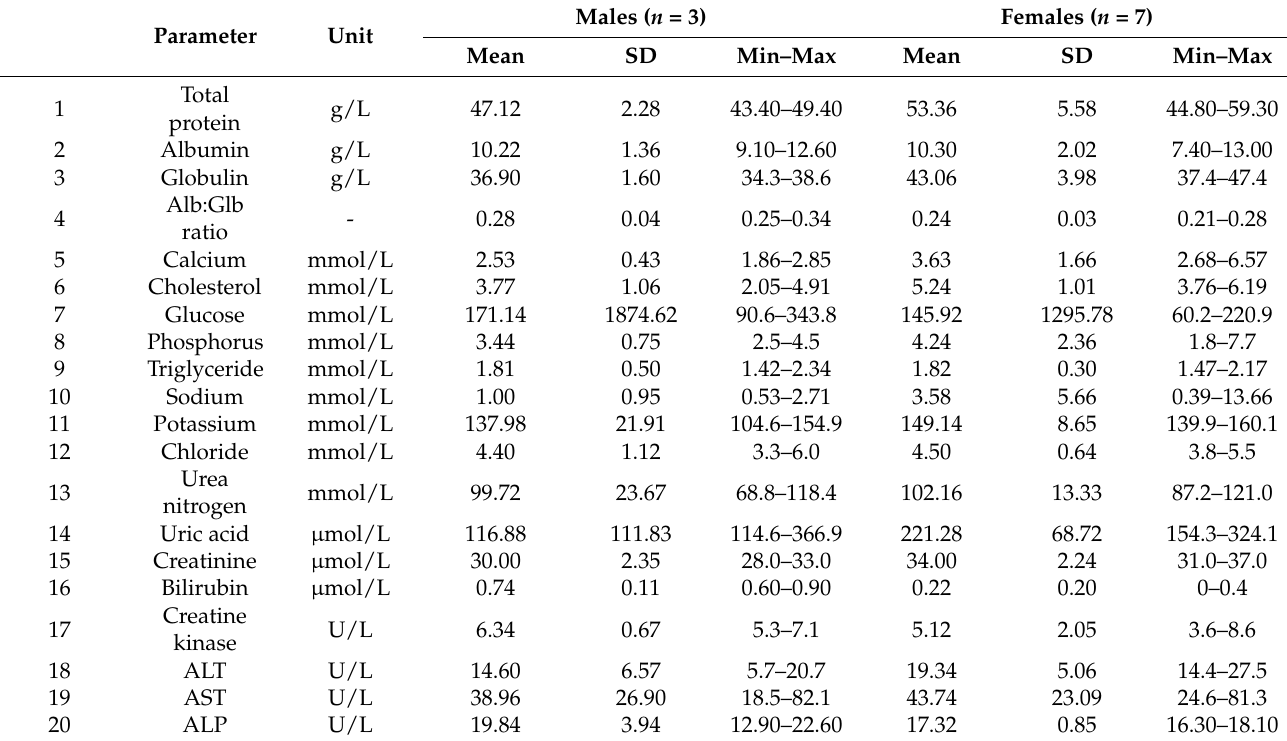
Table 6. Comparison of the Biochemical Values between Male and Female False Gharial ( n = 10). For each parameter the mean and the standard deviation (SD), as well as the minimum (Min) and maximum (Max) range are